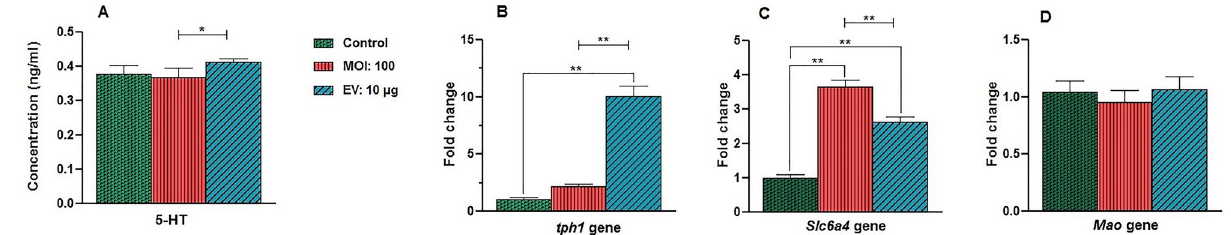
Figure 6. In vitro serotonin, availability was regulated by A. muciniphila and its EVs. The monolayer Caco-2 cell line was exposed to ( A ) A. muciniphila (MOI100) and EVs (10 μg) for 24 h. The figure represents the expression of ( B ) Tph1 , ( C ) Slc6a4 , and ( D ) Mao genes. The gene expression data are normalized relative to the GAPDH gene as the control (*P < 0.05 and **P < 0.01 indicated statistical